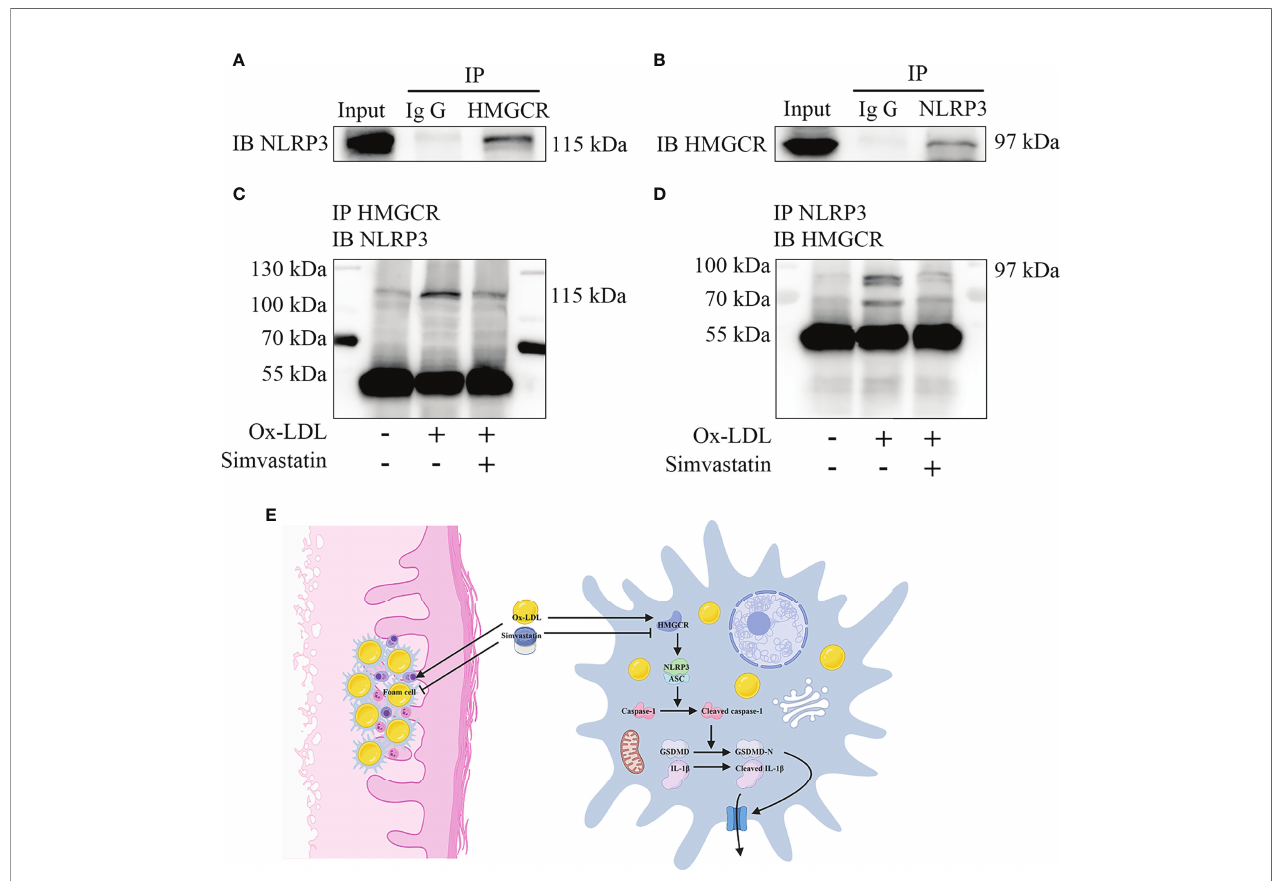
FIGURE 6 | Mechanism underlying the effects of simvastatin. (A, B) Immunoprecipitation showed an interaction between NLRP3 and HMGCR. (C, D) Simvastatin inhibited the interaction between NLRP3 and HMGCR. (E) Schematic model of the effects of